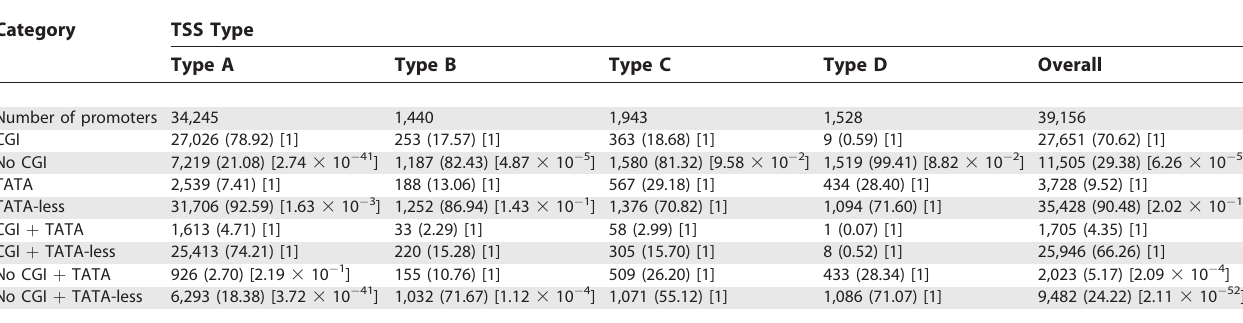
Table 3. Basic Statistics on Relation of TATA Box Motifs, CGIs, and Four TSS Types for MM5 Transcripts Category